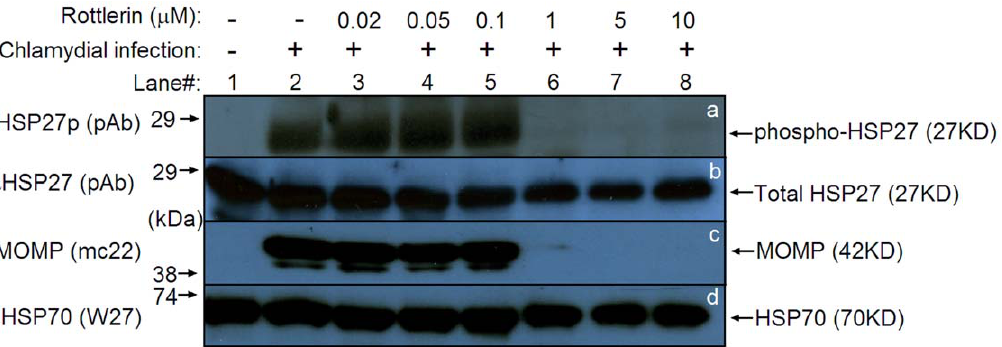
Figure 1. Rottlerin inhibits both HSP27 phosphorylation and chlamydial growth. HeLa monolayer cells grown in 24 well plates were infected with or without Chlamydia trachomatis infection (MOI=1) and 16 h post infection, the cultures were treated with or without rottlerin at different concentrations as indicated on top of the figure. The culture samples were harvested 48 h post infection and analyzed on Western blot for detection of phosphorylated HSP27 (phospho-HSP27, panel a), total HSP27 (b), chlamydial major outer membrane protein (MOMP, c) and host HSP70 as a loading control (d) with the corresponding antibodies as listed in the left of the figure. Note that neither phospho-HSP27 nor MOMP was detectable in the infected cultures treated with 1 m M or higher concentrations of rottlerin (lanes